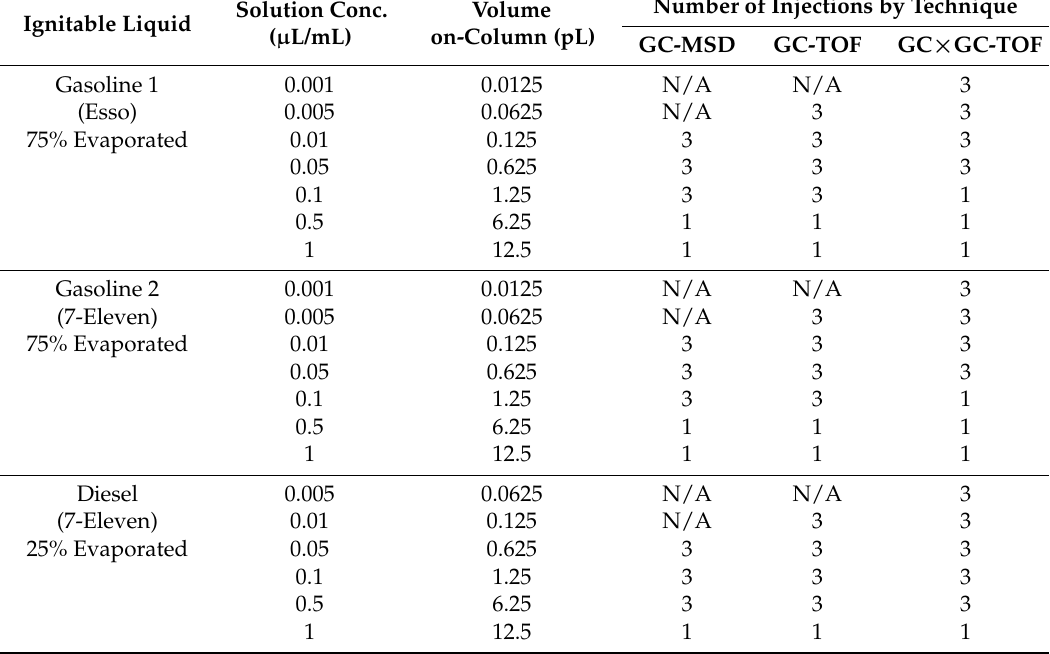
Table 2. The scheme used for analysis of the ignitable liquid standards, showing concentration in-vial, the nominal on-column volume after injection, and the number of injections performed at each concentration on each instrument. This scheme was followed for the pure ignitable liquid dilutions, and repeated for the pyrolysate-doped series. N/A represents concentrations not analyzed on those respective